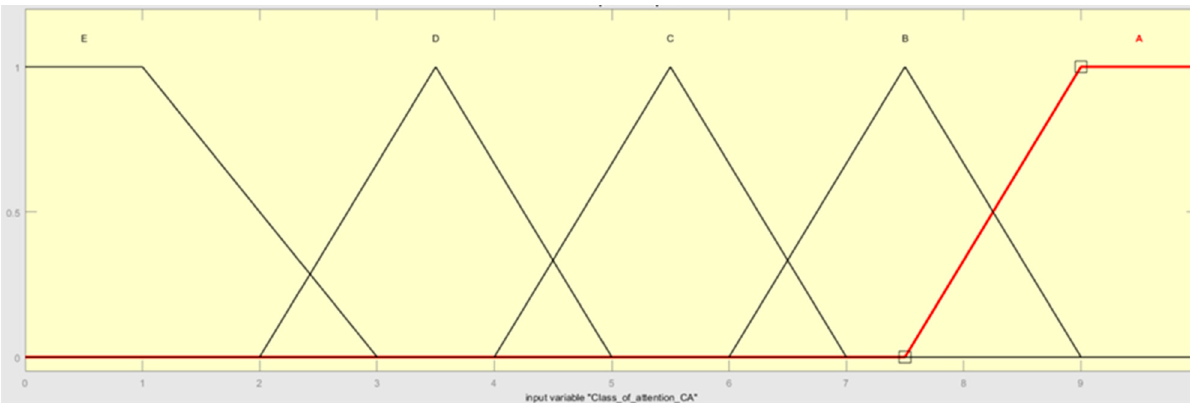
Figure 7. The class of attention fuzzy